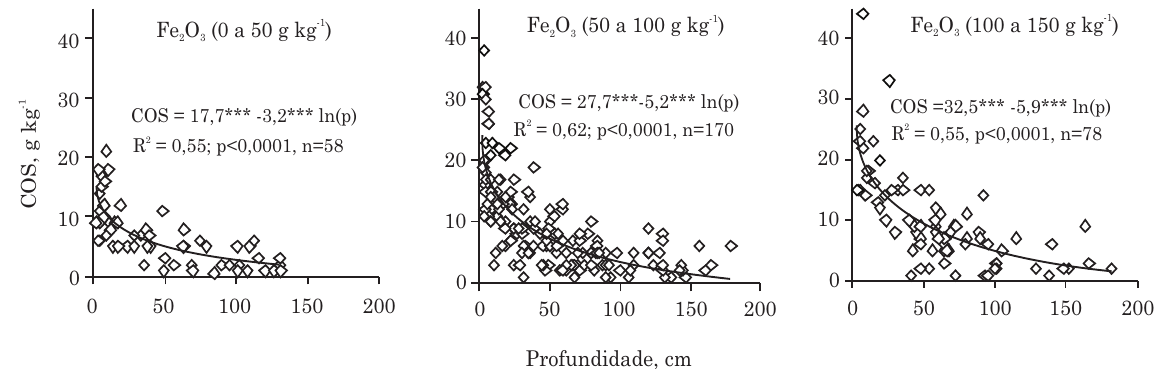
Figura 8. Perfis de carbono orgânico do solo (COS) para três faixas de teor de Fe 2 O 3 do ataque sulfúrico na região Sul de MG. O nível de significância para os parâmetros intercepto e fator logarítmico é representado por *,** e ***, respectivamente, para p<0,05, p<0,01 e